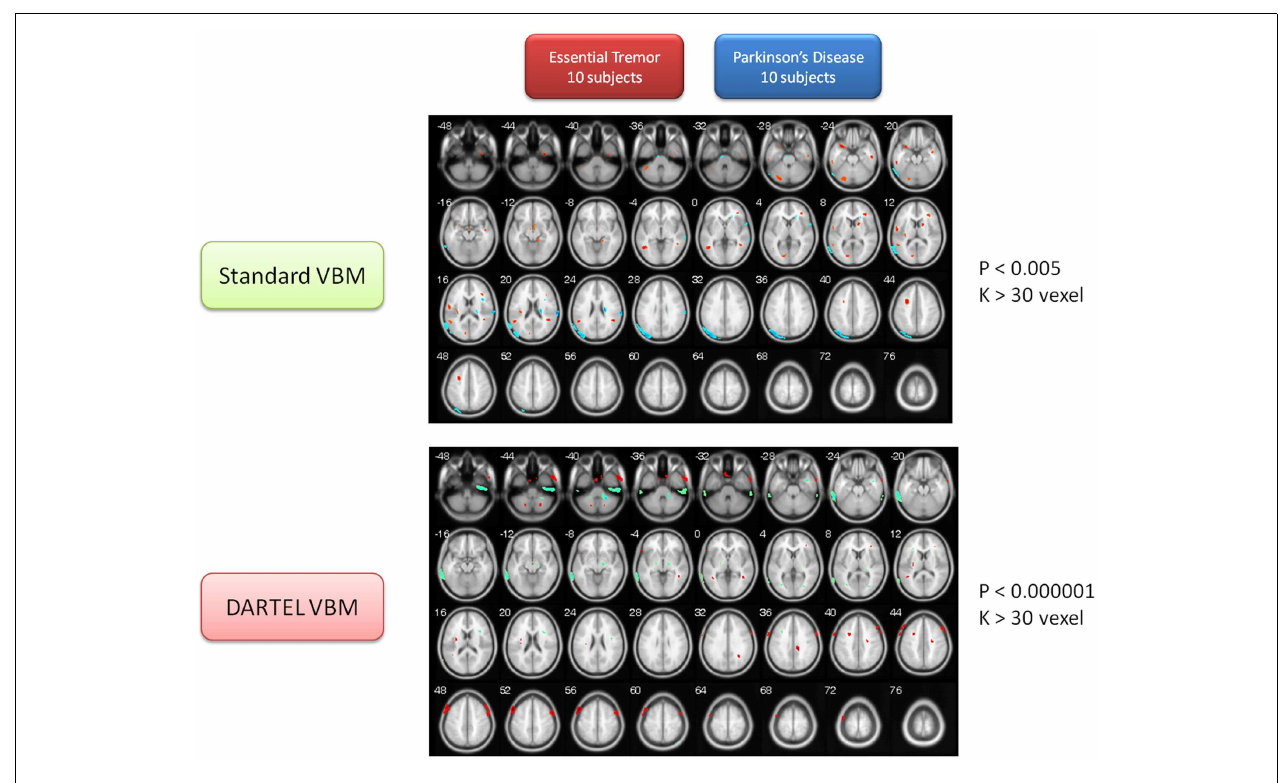
lobe, and cerebellum of ET were larger than that of PD in bothVBM methods (see also Figure 3 ). Moreover, the both methods demonstrated that the parietal cortex, temporal cortex, and thalamus of PD were larger than that of ET.The finding on thalamus is consistent with the previous result in comparison between PD patients and healthy control (see also Figure 2